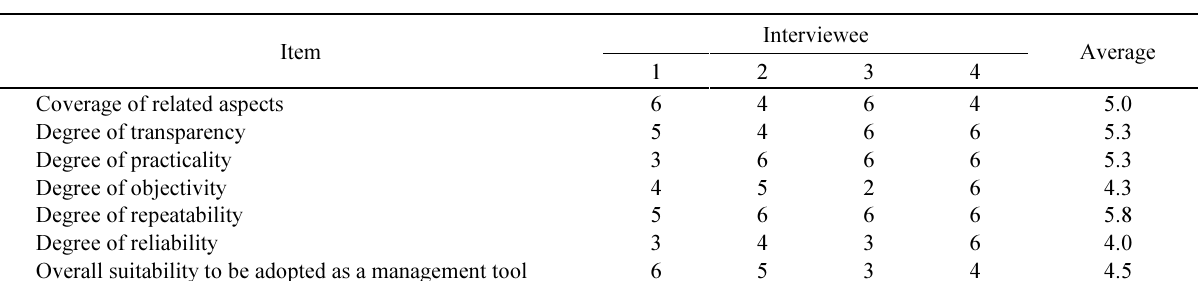
Table 5. Validation